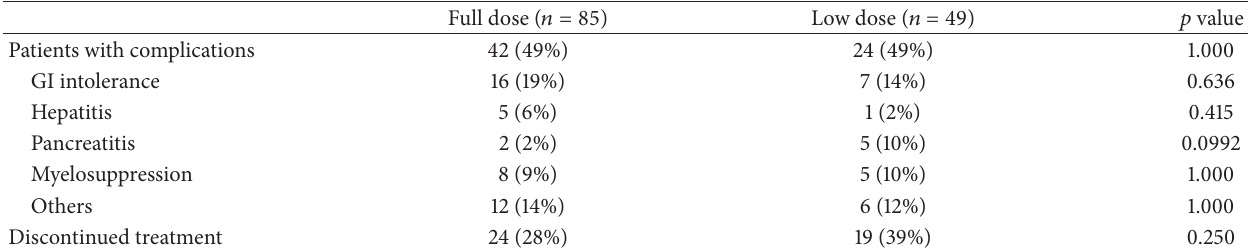
Table 2: Side effect profile of thiopurine therapy over study period.